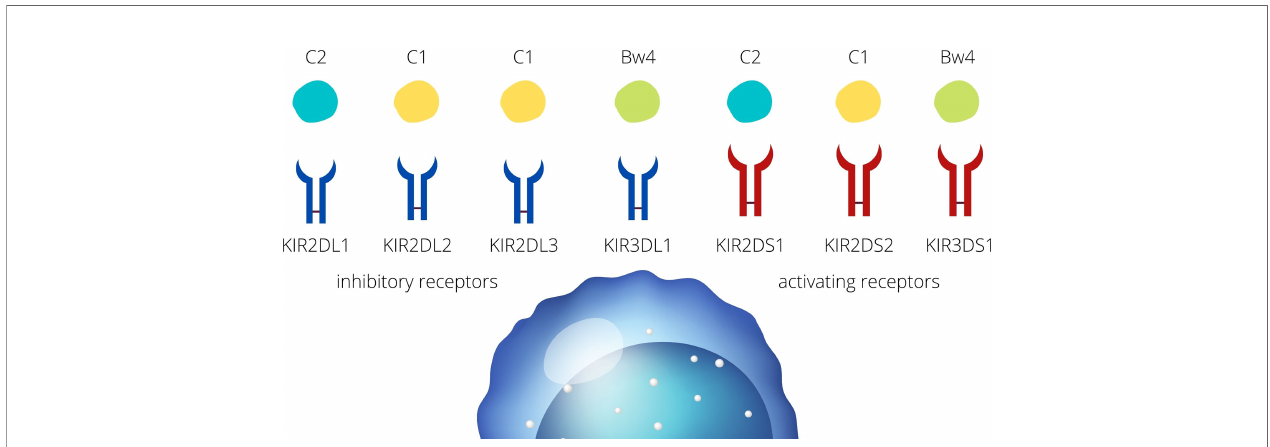
FIGURE 1 | KIR- HLA interactions. KIR receptors present on the NK cells are divided into inhibitory and activating receptors. HLA ligands for the KIR receptors are classi fi ed into HLA-C1, -C2, and